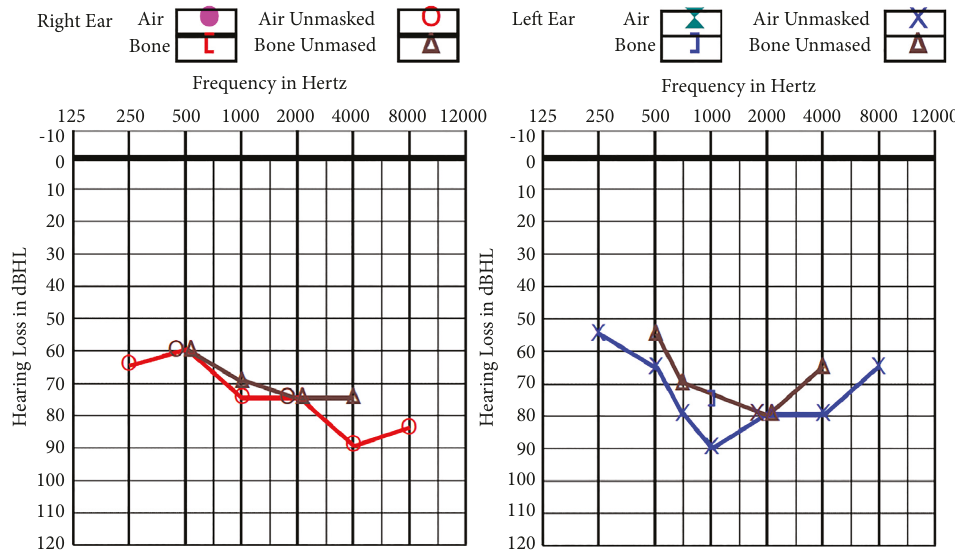
Figure 2: Audiogram at presentation at 6 years of age. Bilateral severe sensorineural hearing loss at 60–90dB.